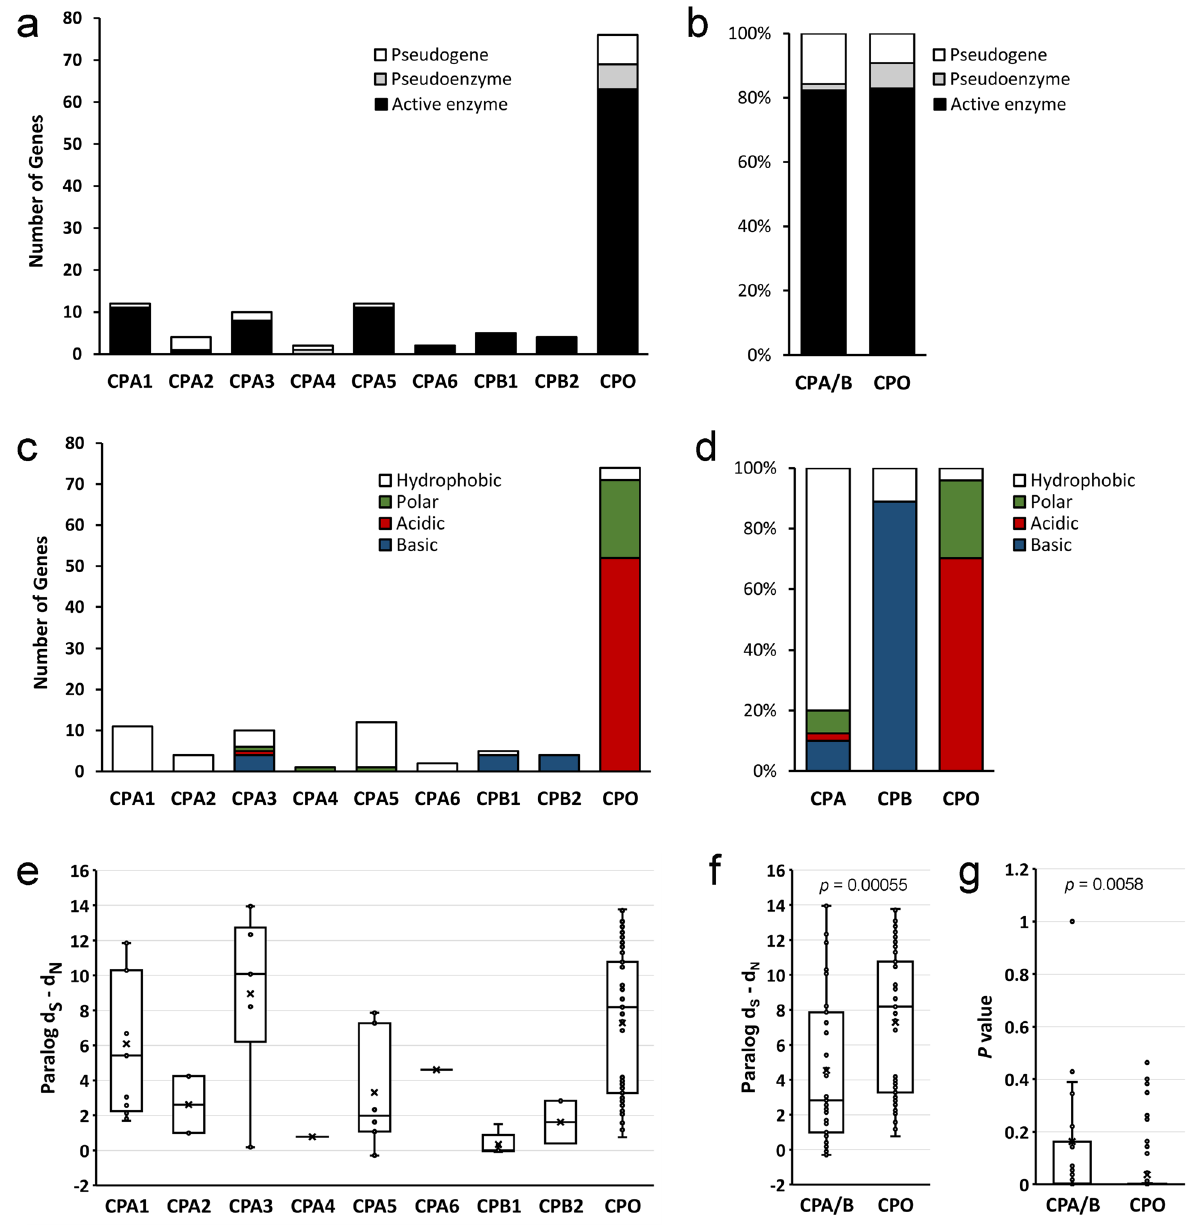
Figure 5. Indicators of gene function suggest changes in metallocarboxypeptidase paralog activity and specificity, yet purifying selection to maintain function. Predicted cDNA and amino acid sequences were curated for all duplicated members of the A/B subfamily of metallocarboxypeptidases found in Ensembl. ( a , b ) Predicted proteins were classified as active enzymes, pseudoenzymes (containing substitutions at active site residues), or pseudogenes (containing large deletions or other deleterious structural mutations). ( c , d ) Substrate specificity for each predicted protein was predicted based on the identity of the bovine CPA1 residue 255 equivalent. Hydrophobic = hydrophobic residue 255; acidic = basic residue 255; basic = acidic residue 255; polar = polar residue 255. ( e , f ) The predicted coding sequences for each paralog pair were used in a codon- based test of purifying selection, where greater Ds–dN indicates greater probability of purifying selection. The variance of the difference of synonymous and nonsynonymous substitutions per site was computed using the analytical method. Analyses were conducted using the Nei–Gojobori method in MEGA7. ( g ) The probability of rejecting the null hypothesis of strict-neutrality (dN = dS) in favor of the alternative hypothesis (dN < dS, purifying selection) is shown. A t-test was used to compare CPO paralogs with all